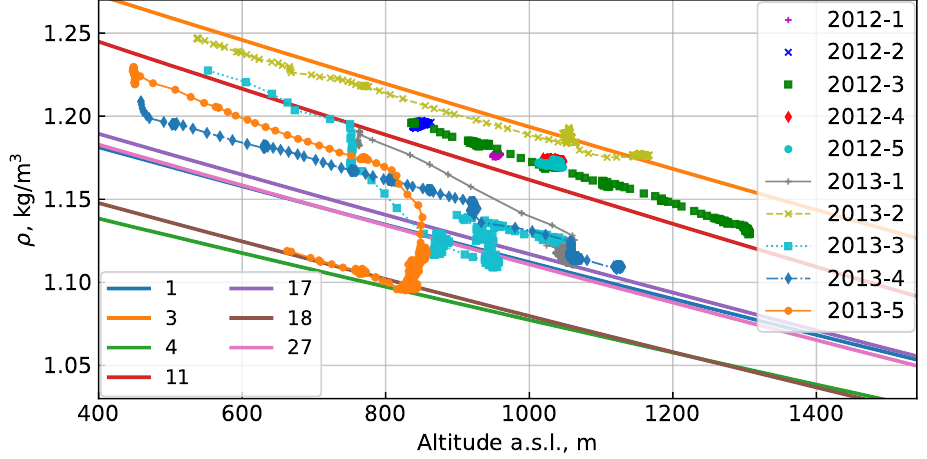
Figure 18. Density versus altitude experimental data (points) in each flight and CORSIKA model density profiles (solid lines) same as in Figure